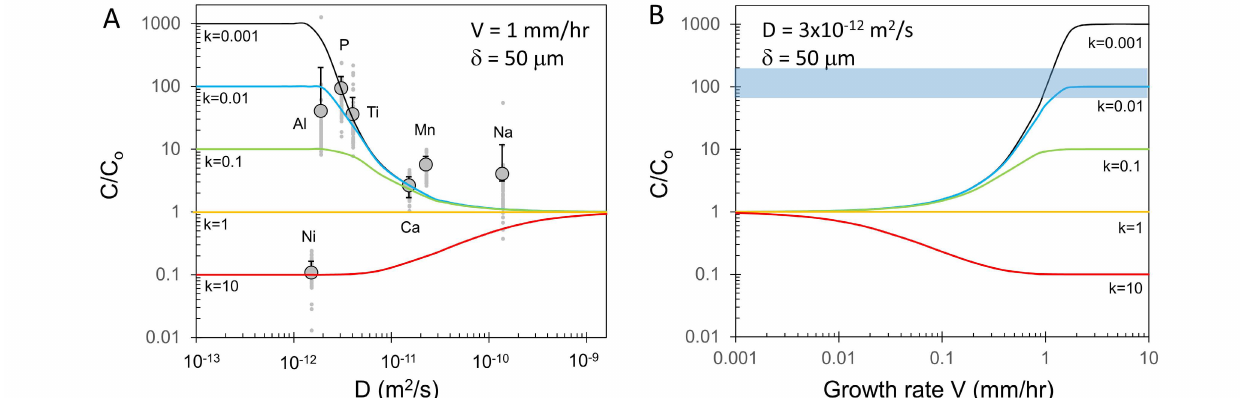
Figure 4: Models of trace-element incorporation during rapid crystal growth. [A] Vertical axis represents enrichment or depletion of element in swallowtail olivine relative to equilibrium conditions by normalizing concentrations in the swallowtail olivine ( C ) to concentrations in olivines from cumulate peridotite xenoliths ( C o ). Enrichment/depletion factors ( C / C o ) in olivine plotted against diffusivity in basaltic melt at 1200 °C using diffusion parameters from the literature [Lowry et al. 1982; Chen and Zhang 2008; Behrens and Hahn 2009; Zhang et al. 2010; Watson et al. 2015]. Curves represent steady state enrichment/depletion during rapid crystal growth. A crystal growth rate of 1 mm/h was estimated from the length scales of the oxidized xenolith rinds (see text). A boundary layer δ of 50 µ m was assumed based on elemental maps (see text and Figure 1C). Different colored lines correspond to different mineral/melt equilibrium partition coefficients k . Compatible elements ( k > 1) become depleted in growing crystal while incompatible elements ( k < 1) become enriched. [B] Models of enrichment/depletion within olivine versus crystal growth rate for a diffusivity of 3 × 10 -12 m 2 /s in the melt. This diffusivity corresponds with the diffusivity of P in basaltic melt at 1200 °C. Boundary layer thickness as in [C].